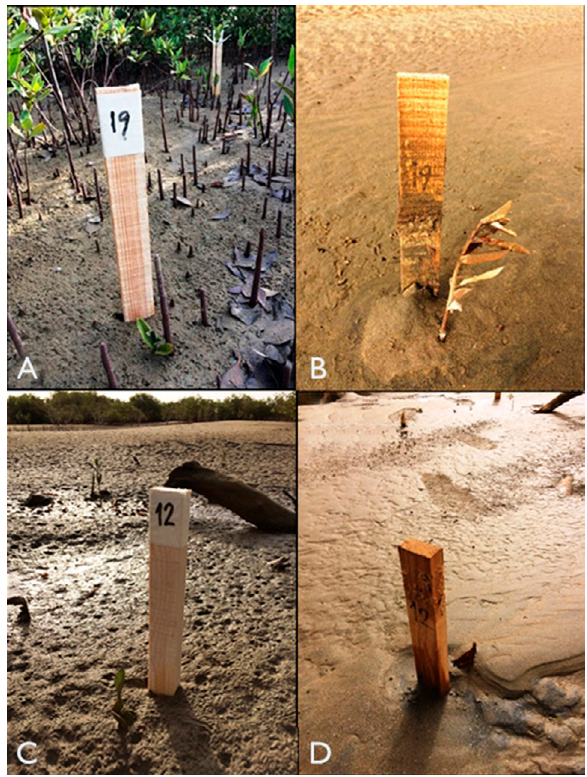
Fig. 4. – Representative seedling images of before (A, C) and after (B, D)